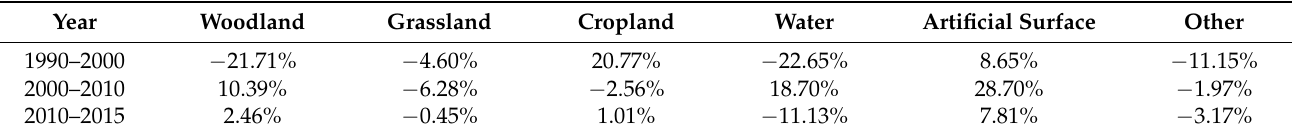
Table 2. Rate of change in different land cover types in the Yellow Diversion Irrigation Area.